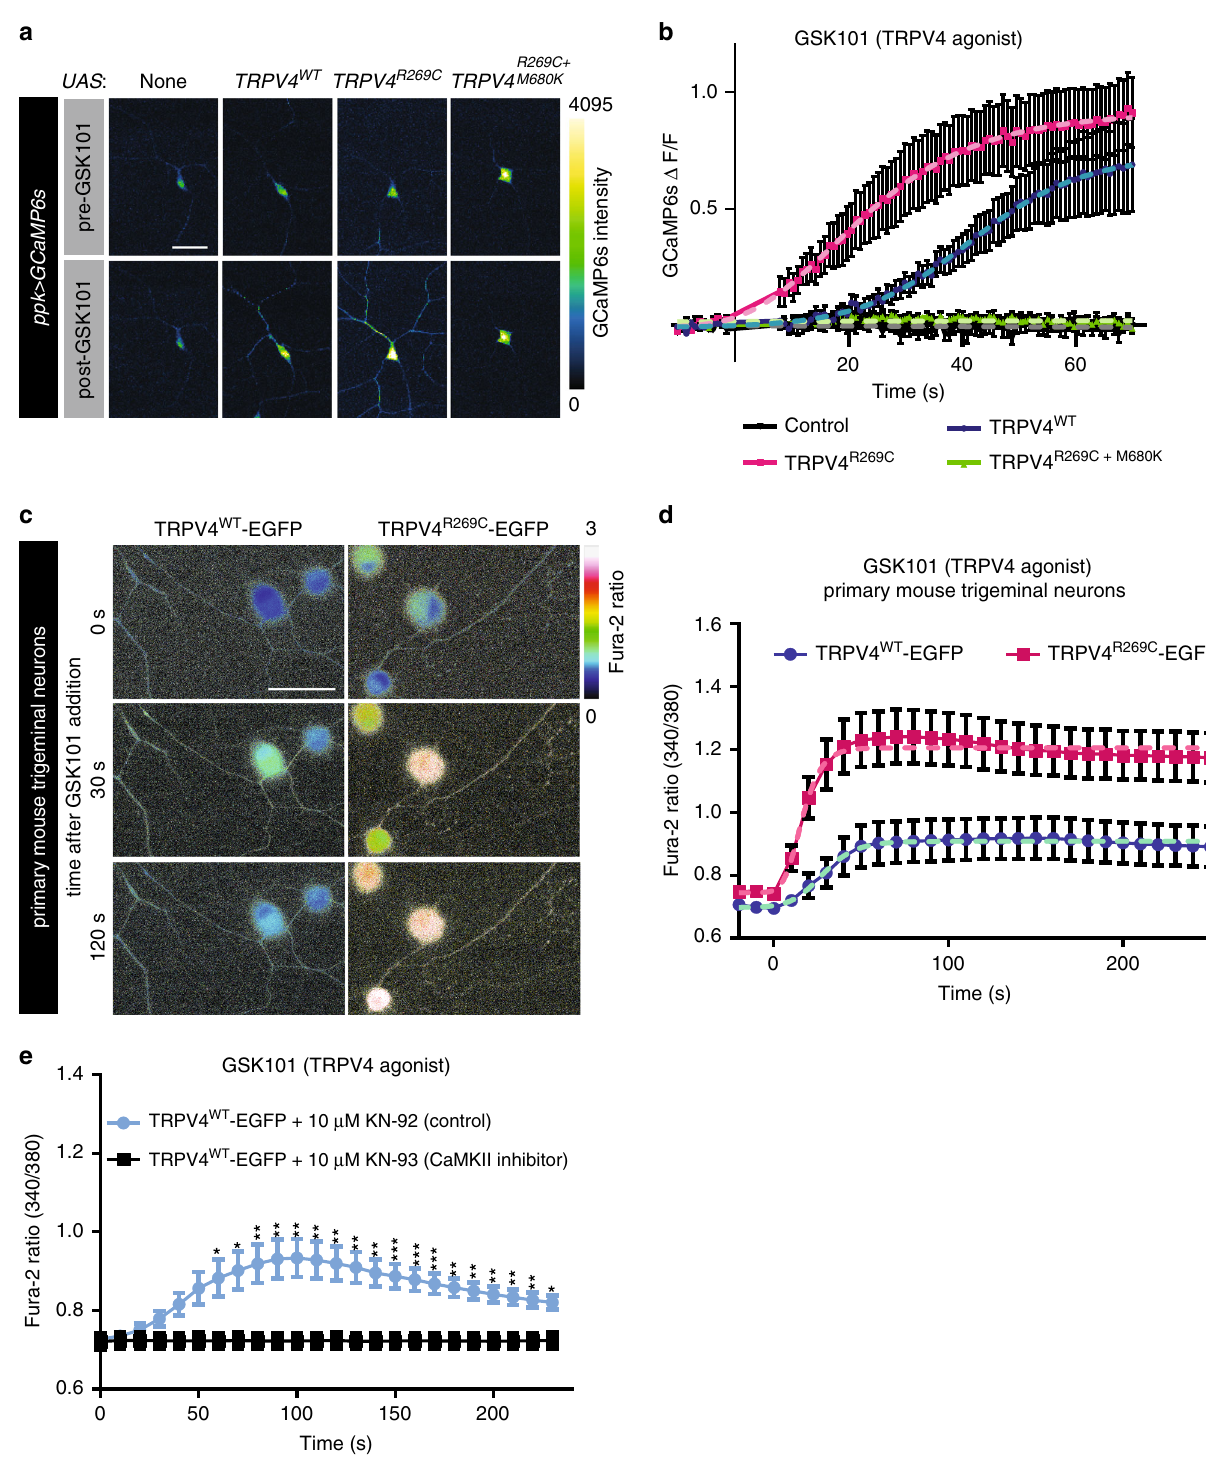
in vitro, consistent with the gain-of-ion channel